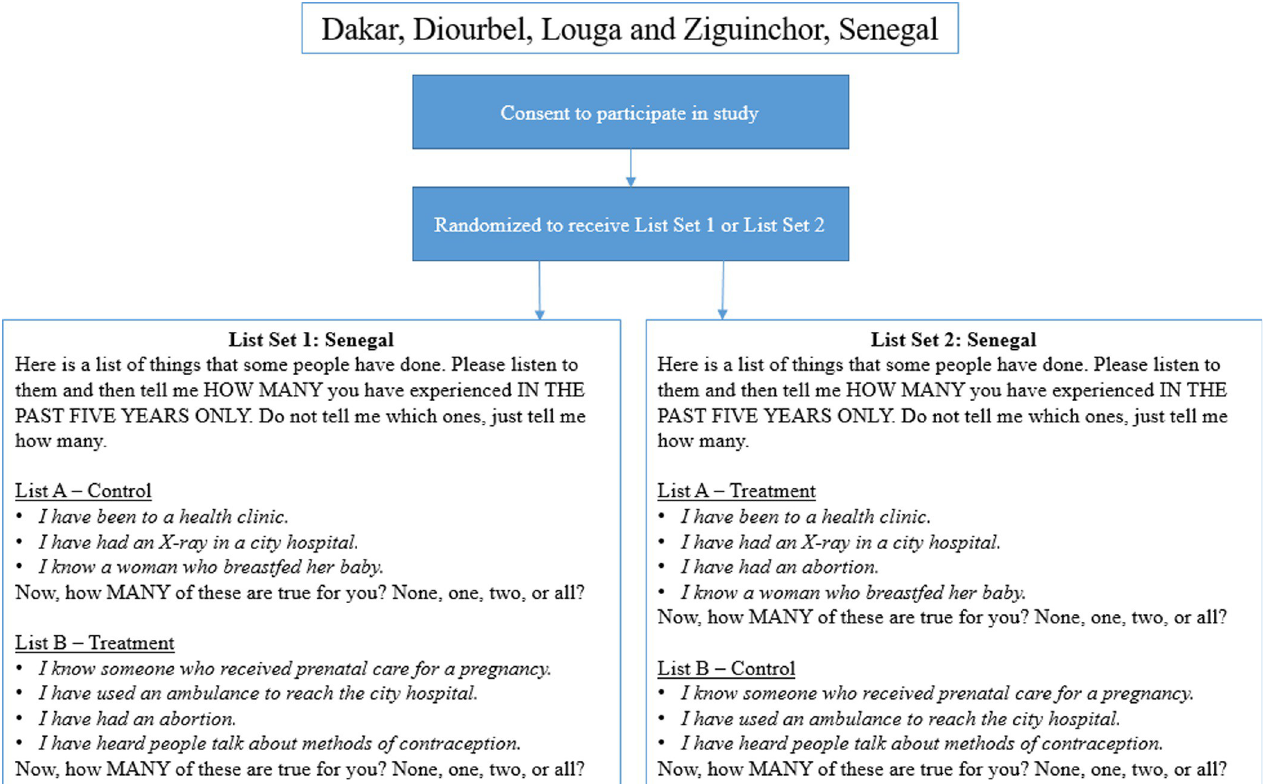
Fig 2. Diagram indicating participant randomization to one of two list experiment sets, as well as the full text of the list experiment questions. List experiment sets presented below for the Senegal survey.